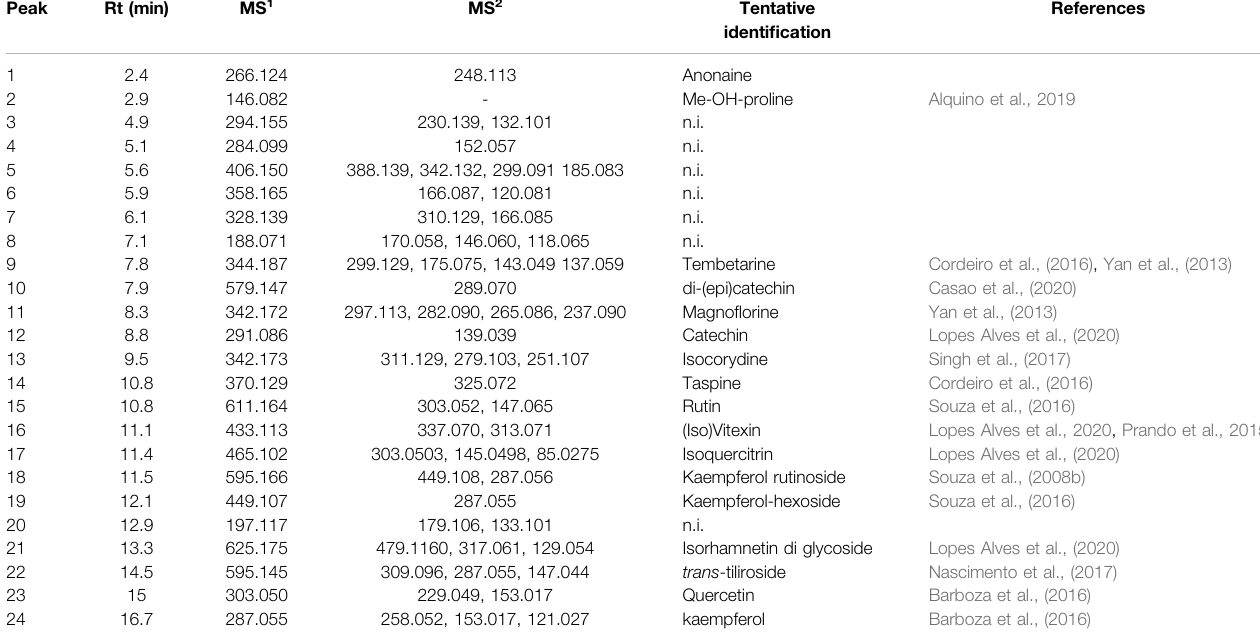
TABLE 1 | Analysis of phytochemicals identi fi ed in Croton urucurana , determined by LC-MS, with positive ion mass spectra results and tentative identi fi cation of each compound. Peak Rt